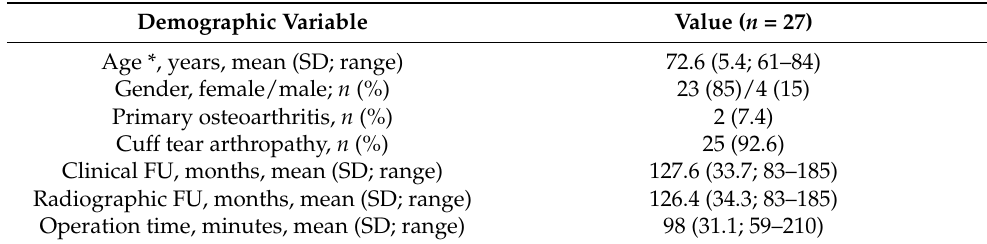
Table 1. Demographics and characteristics of the study cohort. Age * = age at the time of implantation; SD = standard deviation; FU =